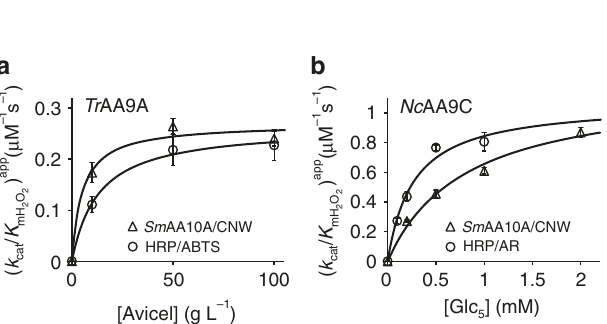
Fig. 4 Apparent k cat / K mH values for Tr AA9A/Avicel and Nc AA9C/ 2 O 2 Glc5 measured using different reference reactions. a Apparent k cat / K values for Tr AA9A/Avicel measured using the Sm AA10A/CNW or mH 2 O 2 the HRP/ABTS reference reaction. b Apparent k cat / K mH values for 2 O 2 Sm AA10A/CNW or the HRP/AR Nc AA9C/Glc 5 measured using the reference reaction. Solid lines show nonlinear regression of the data according to Eq. (7). Apparent k cat / K values and their errors (SD) were calculated mH 2 O 2 from corresponding [ E ] 50 values and their associated errors that were derived from nonlinear regression analysis (for details see Source Data fi